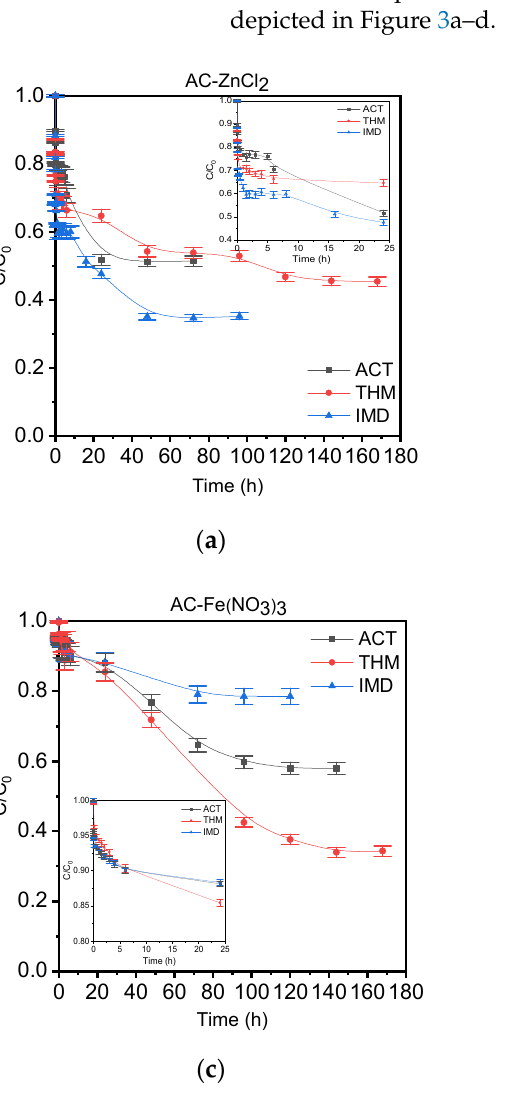
Figure 3. Adsorption kinetics of the three pesticides onto the ( a ) AC-ZnCl 2 , ( b ) AC-FeCl 3 , ( c ) AC-Fe(NO 3 ) 3 , and ( d ) AC- Fe 2 (SO 4 ) 3 activated carbons.